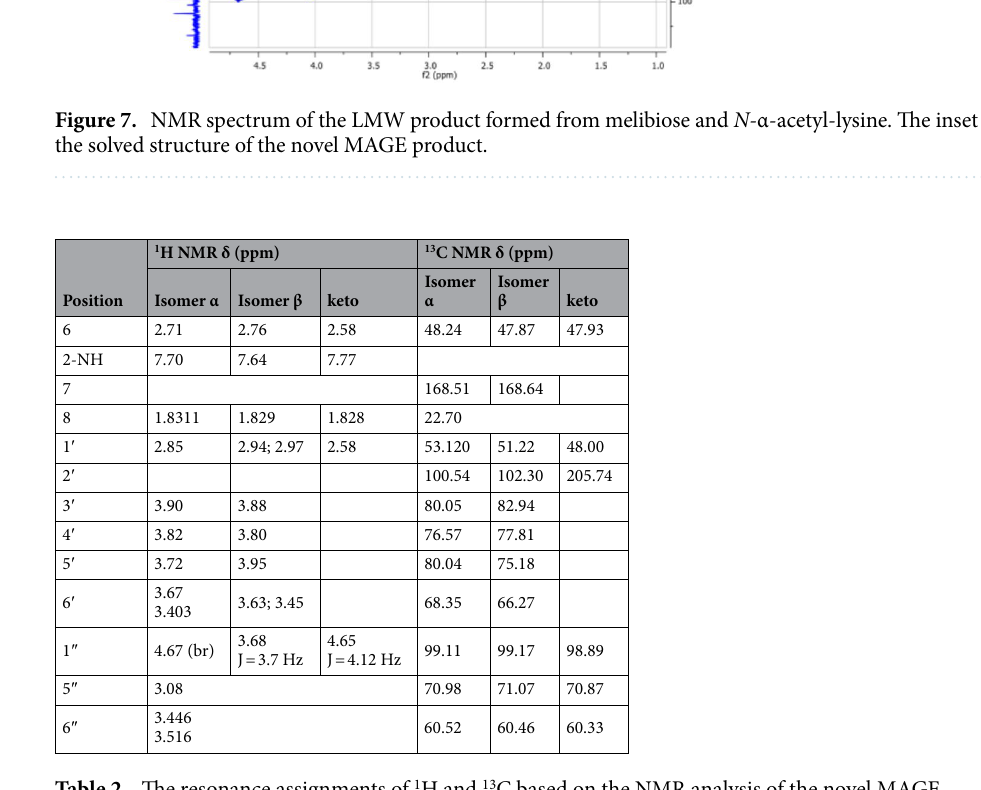
Table 2. The resonance assignments of 1 H and 13 C based on the NMR analysis of the novel MAGE.